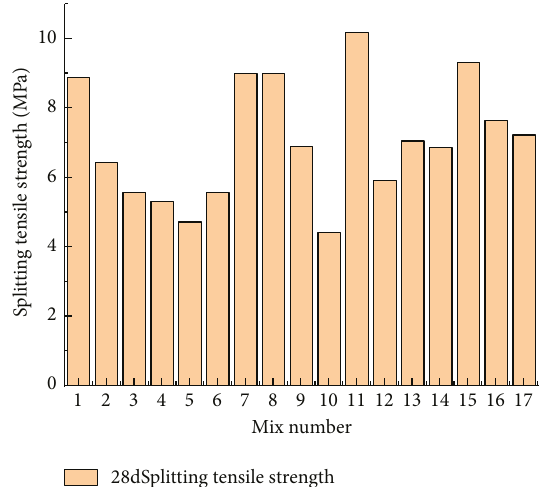
Figure 9: Splitting tensile strength of different mixing ratios.